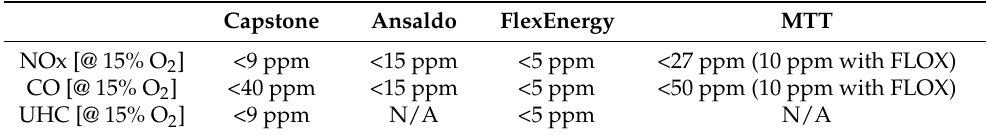
Table 2. Baseload emissions for different micro gas turbine systems [21]. Capstone